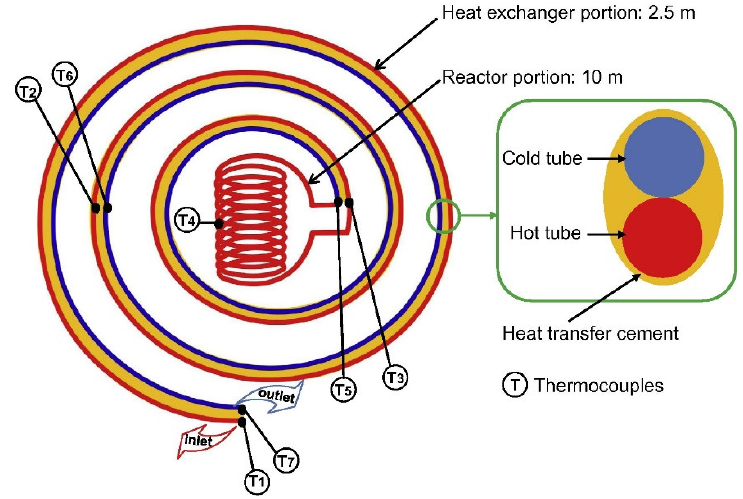
Figure 3. Spiral reactor [68]. Reprint with permission from ref. [68]. Copyright 2015 Elsevier.